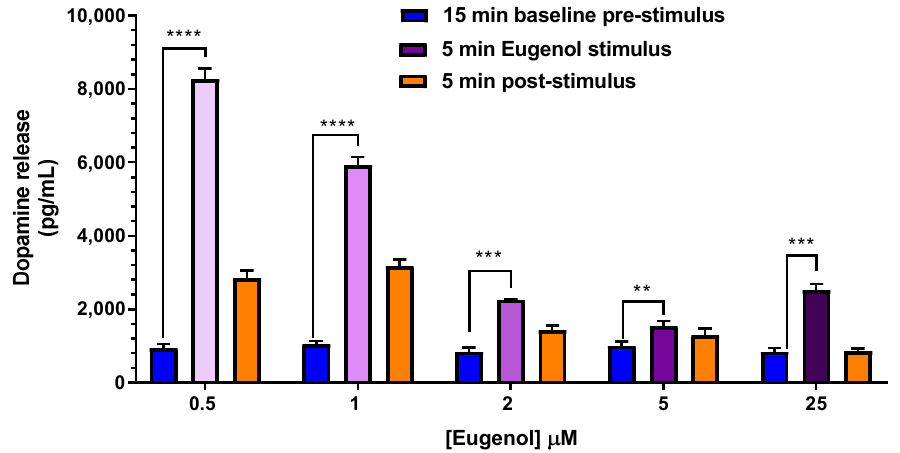
Figure 12. Dose-response curve of dopamine release from PC12 cells. PC12 cells were differentiated to the neuronal phenotype for 14 days, then stimulated with 0.5, 1, 2, 5 and 25 μM eugenol in KRH at 37 °C for 5 min. Each concentration was compared to the basal release of dopamine (947 ± 102 pg/mL). Data are expressed as mean ± SE of three independent experiments, run in duplicate ( n = 6). Data were statistically analyzed by one-way ANOVA, followed by Tukey’s post-hoc multiple comparison test. **** p < 0.0001; *** p < 0.001; ** p < 0.01 of stimulus vs. basal pre-stimulus dopamine release.